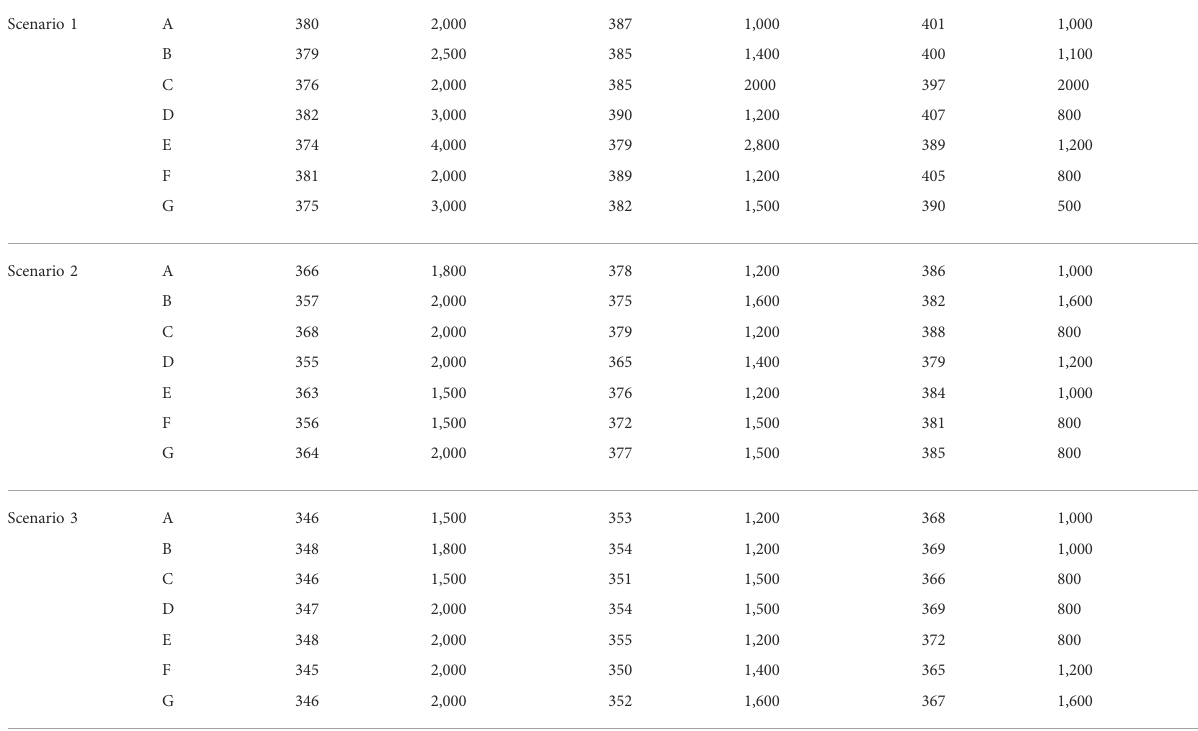
TABLE 2 Buyer ’ s bidding behaviors of three scenarios.